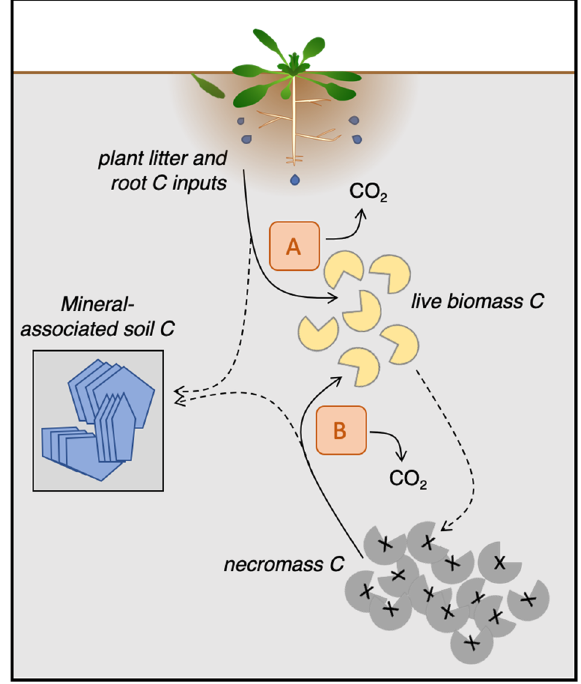
Fig. 1 The path of plant carbon inputs to stable soil carbon. Microbial necromass recycling is a key uncertainty in the stabilization of carbon on soil mineral surfaces. To predict soil carbon stabilization requires quanti fi cation of the microbial carbon use ef fi ciency of plant inputs ( ‘ A ’ ), and microbial necromass ( ‘ B ’